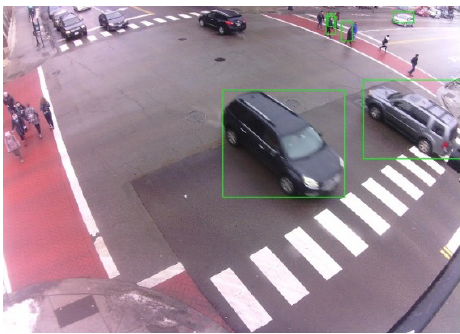
Fig. 3 A typical view from an AoT camera showing object recognition results from edge